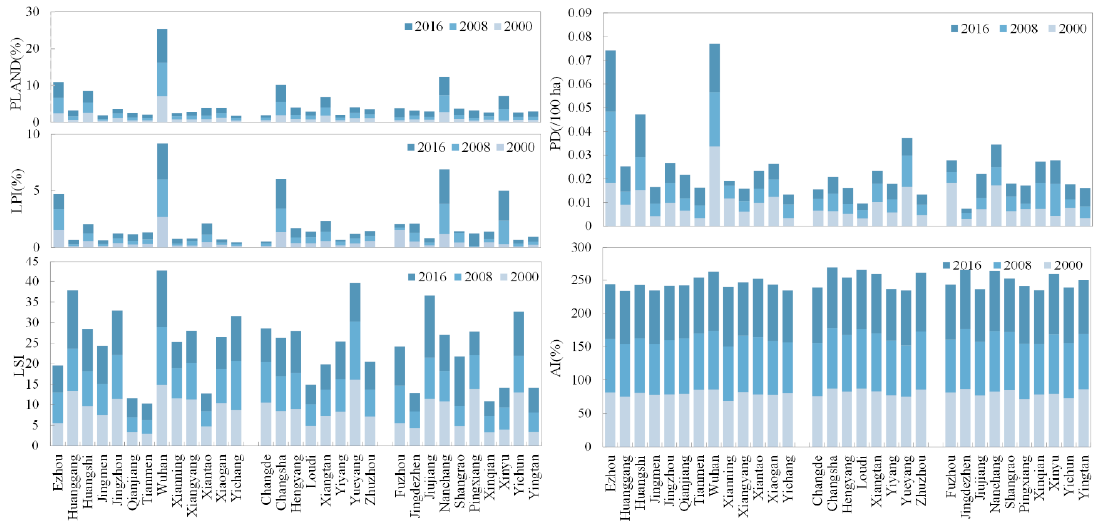
Figure 8. Landscape metrics for the 31 cities during 2000–2016.